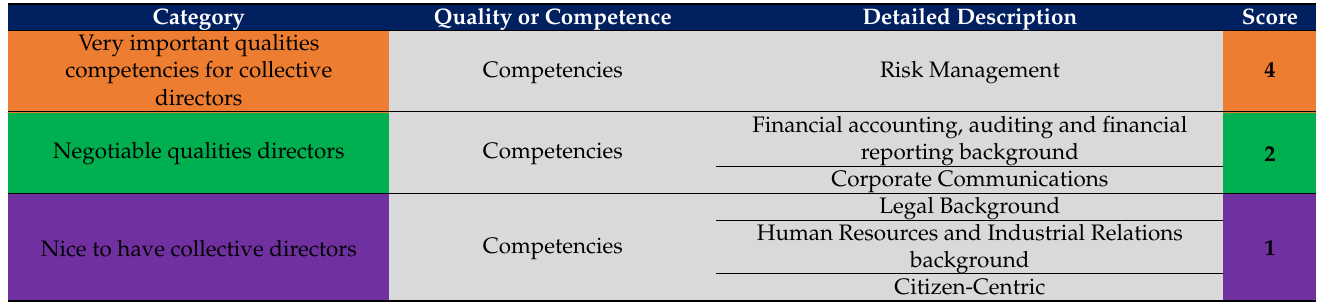
Table 3. Proposed Framework of Evaluating the competencies and qualities of board of directors as a collective in an